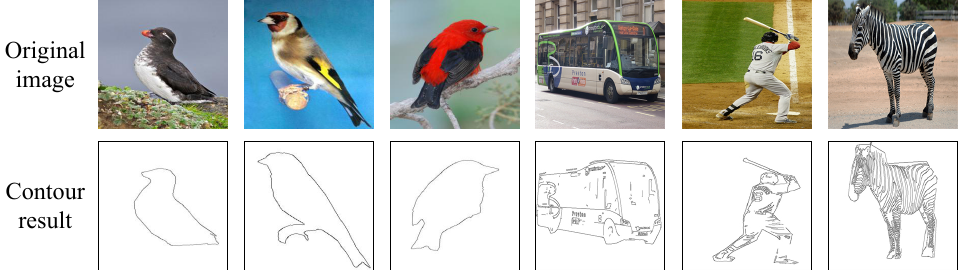
Figure 3. The processed contour results based on the original image are shown